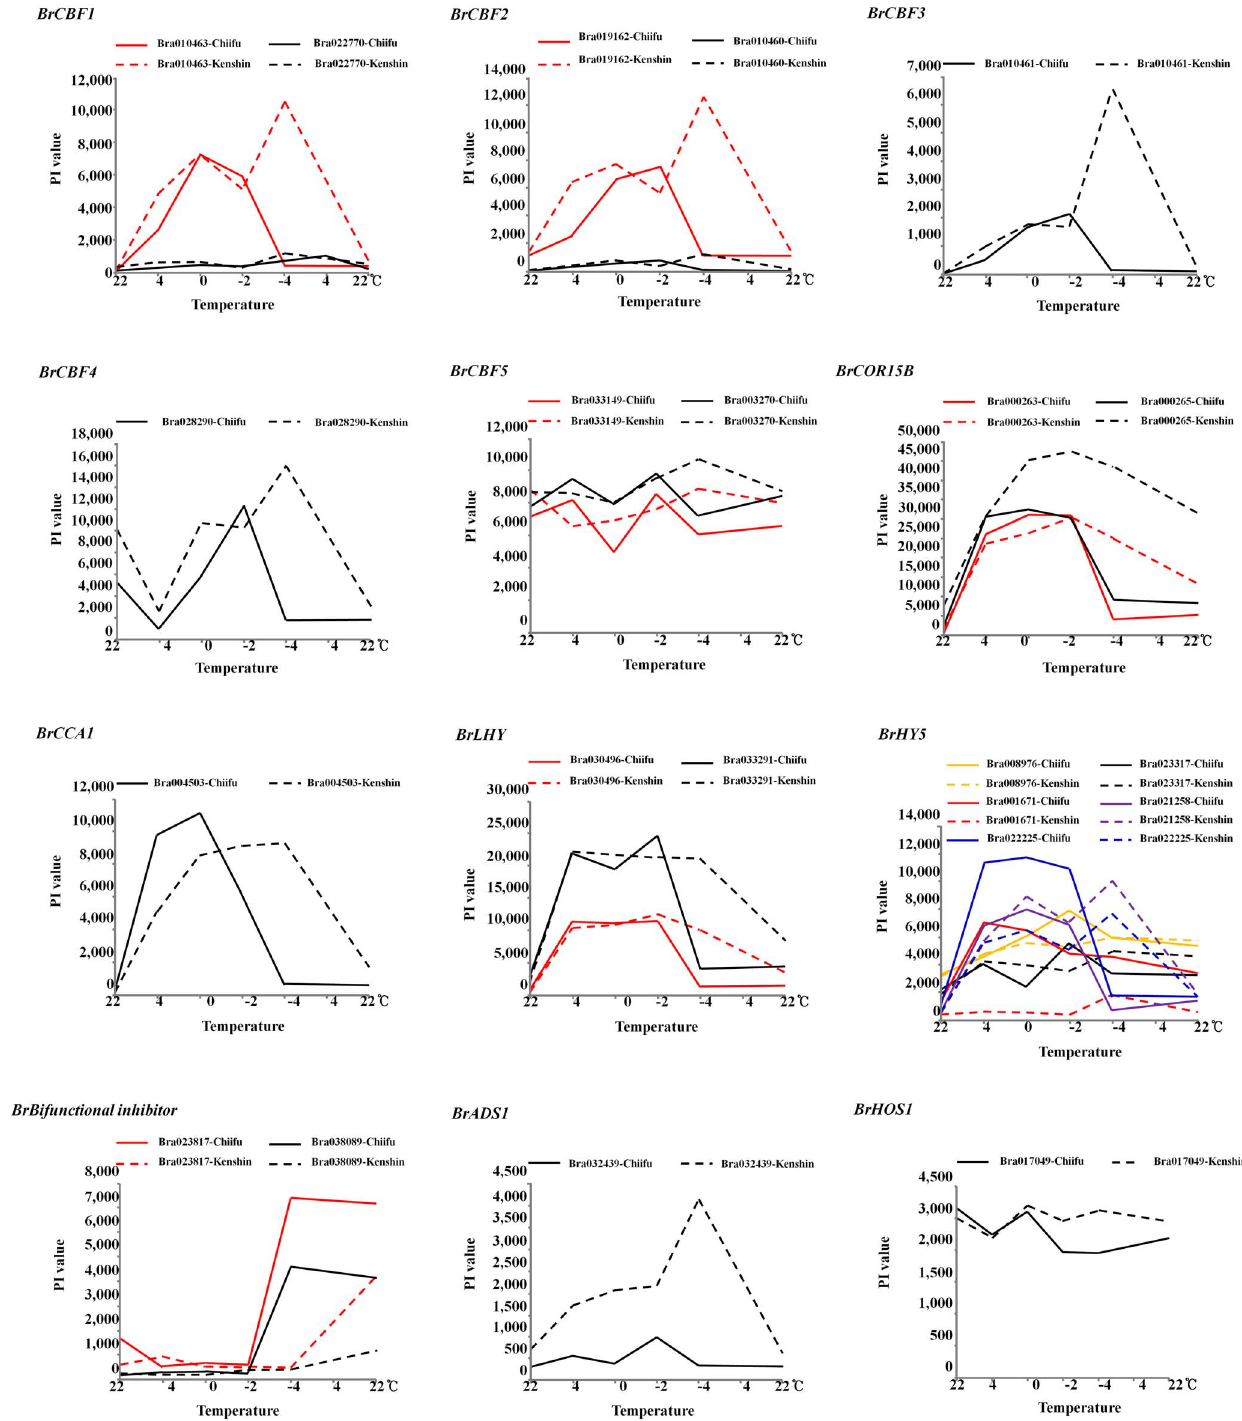
Figure 5. Expression of genes involved in freezing tolerance and genotype specific-expressed genes. PI values were taken from microarray data (Table S1).